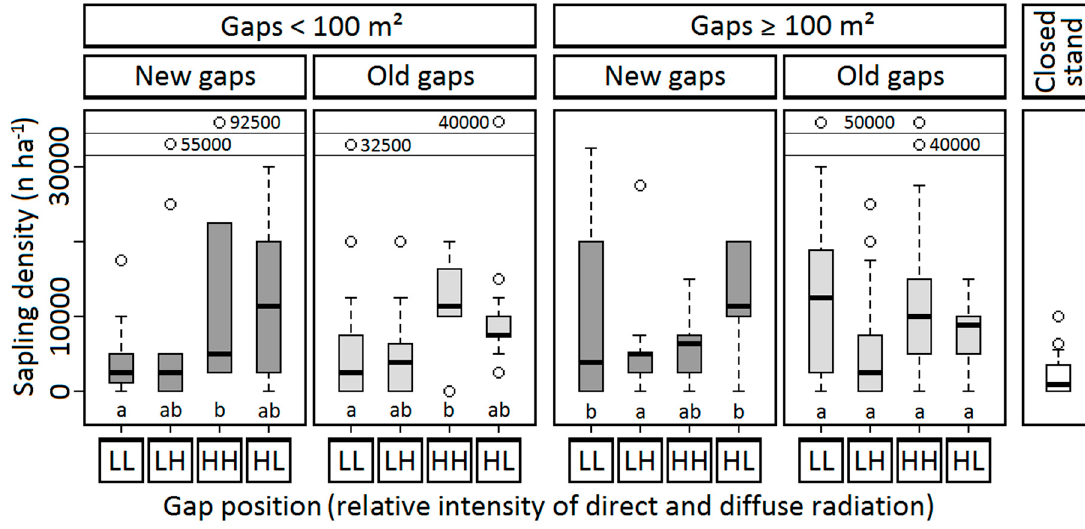
Figure 3. Sapling density in squares at di ff erent position in a gap that formed between 2003 and 2013 (new gaps; dark grey) or prior to 2003 (old gaps; light grey) presented for small ( < 100 m 2 ) and medium-sized gaps ( ≥ 100 m 2 ). The four gap positions are characterized by the availability of di ff erent relative intensities of direct and di ff use radiation (high = H, low = L; first letter for direct and second for di ff use radiation; see Table 1 and Figure 1) following Diaci [38]. The density values of closed-canopy plots are displayed at the right for comparison (32 belt transects á 13 m 2 size). Box-whisker plots with median (thick line), 25-and 75-percentiles (box) and extremes not exceeding the 1.5fold of the interquartile range (whiskers). Dots indicate extreme data points beyond 1.5 times the IQR. Di ff erent letters below the boxes indicate significant di ff erences between the gap positions within gaps of a certain size and age class (linear hypothesis testing).